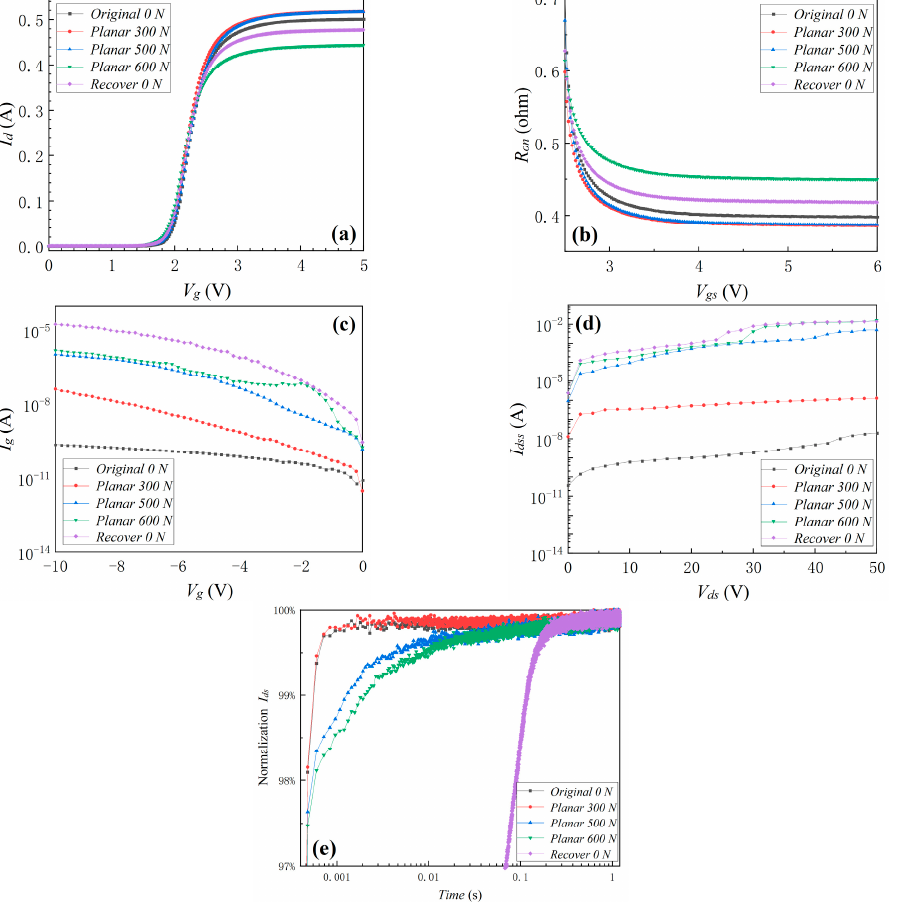
Figure 4. The device’s transfer characteristic ( a ), R on ( b ), I g ( c ), I dss ( d ), and gate-lag characteristics ( e ) before and after planar pressure of 300 and 500 N and recovery to 0 N. ( e ) before and after planar pressure of 300 and 500 N and recovery to 0